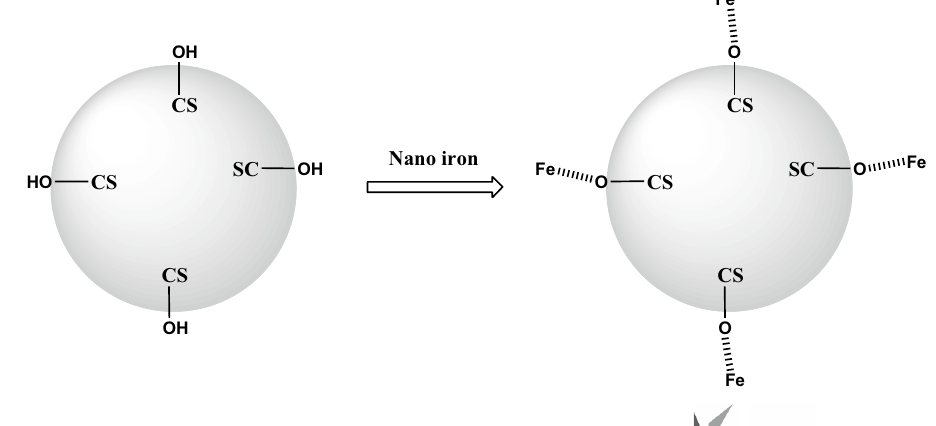
Fig. 1 Synthesis of nanobio-